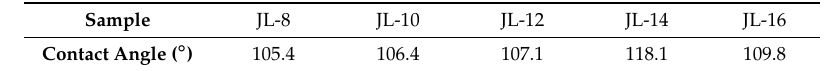
Figure 7. Optical image of a water droplet on JL-14 showing hydrophobicity ( a ), dynamic thermo-mechanical analysis (DMA) curves of pretreated jute (JSE, b ), and DMA curves of JSE laurate (JL, c ). Table 1. Water contact angles of the various